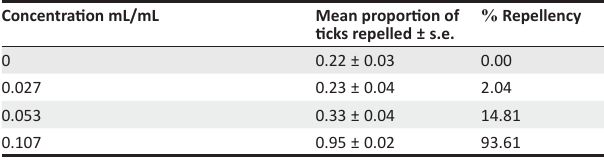
TABLE 2: Dose-dependent repellent response of Hyalomma rufipes (male and female ticks pooled) to Tagetes minuta essential oil. Concentration mL/mL